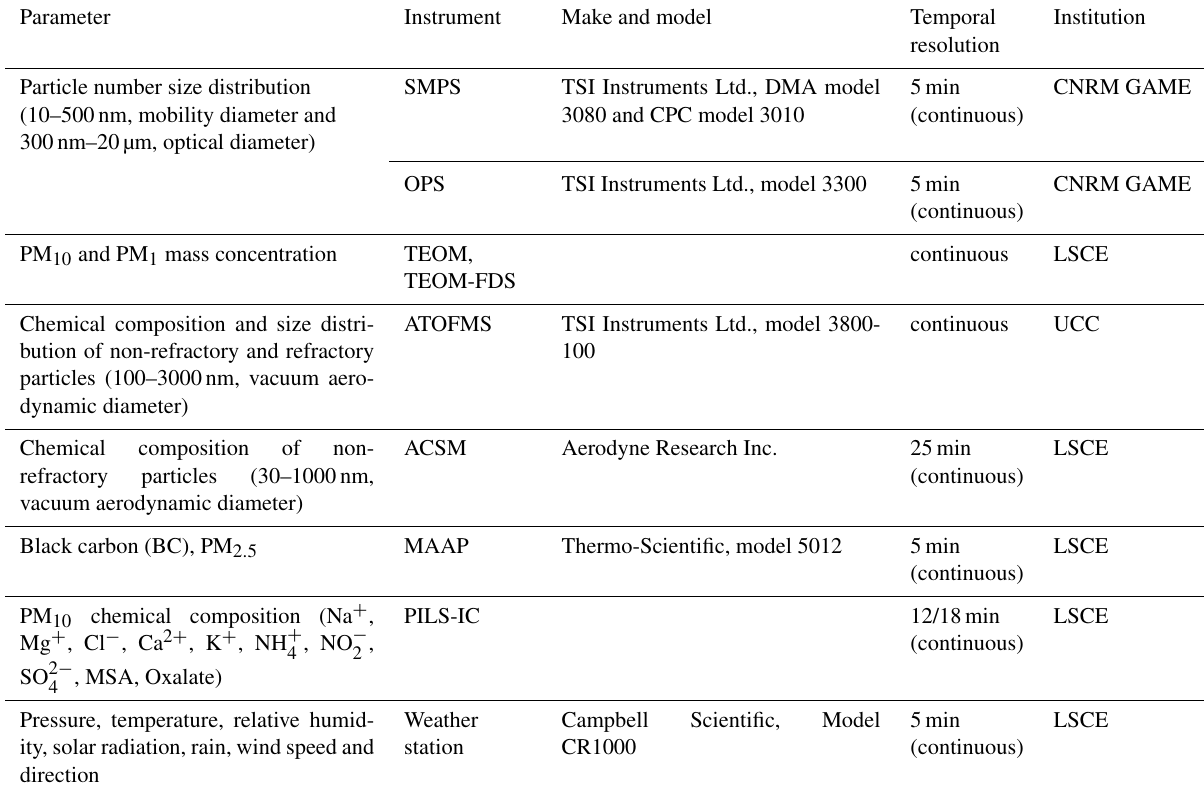
Table 1. List of instruments deployed at Cap Corsica during the ADRIMED and SAF-MED field campaigns. See text for instrument defini-